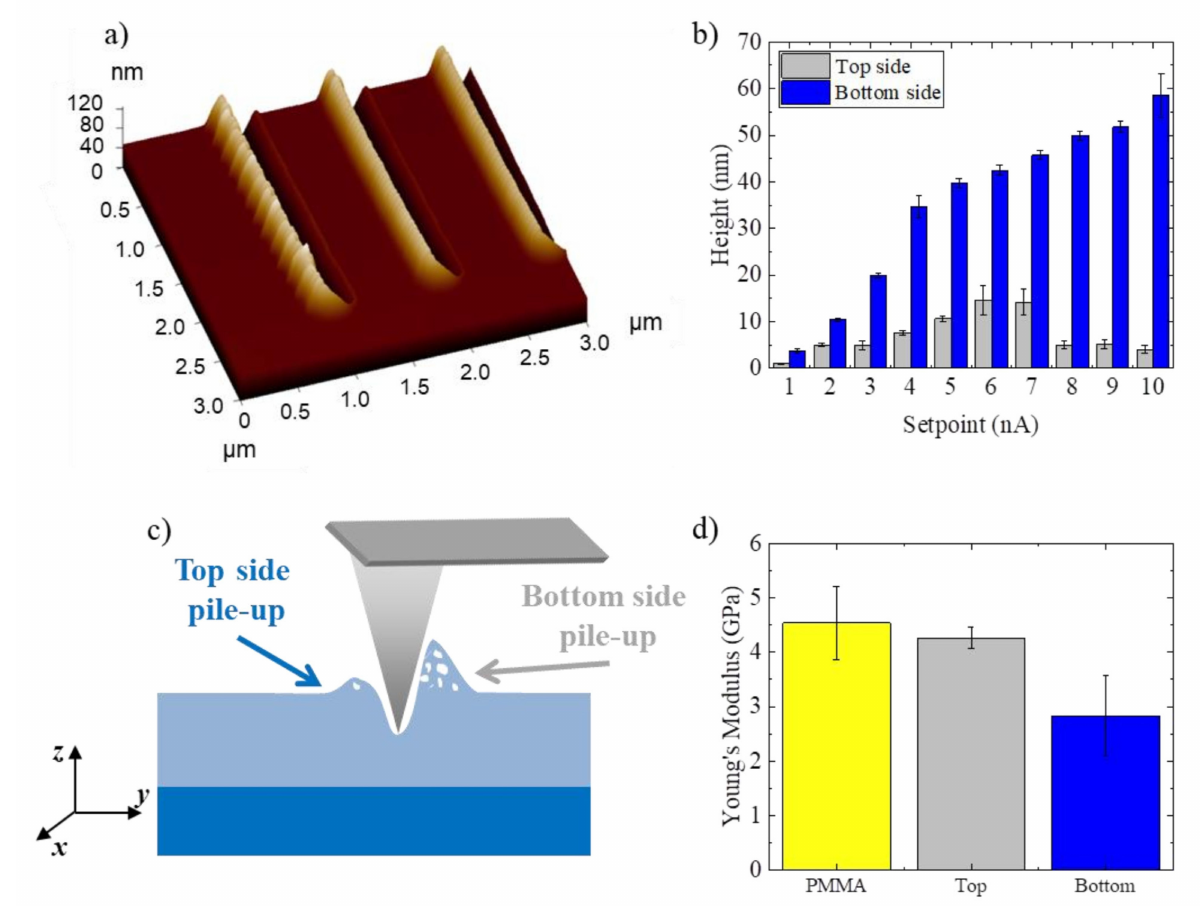
Figure 4. ( a ) 3D AFM topographic image of the deepest nanogrooves. ( b ) Heights of the PMMA pile-ups after nanolithography. ( c ) Schematic representation of the pile-ups formation with cracks. ( d ) Young’s modulus values of the raw PMMA, bottom and top pile-ups. The reported mean values ± SD were calculated for 10 different measures. The data reported were statistically significant for p <